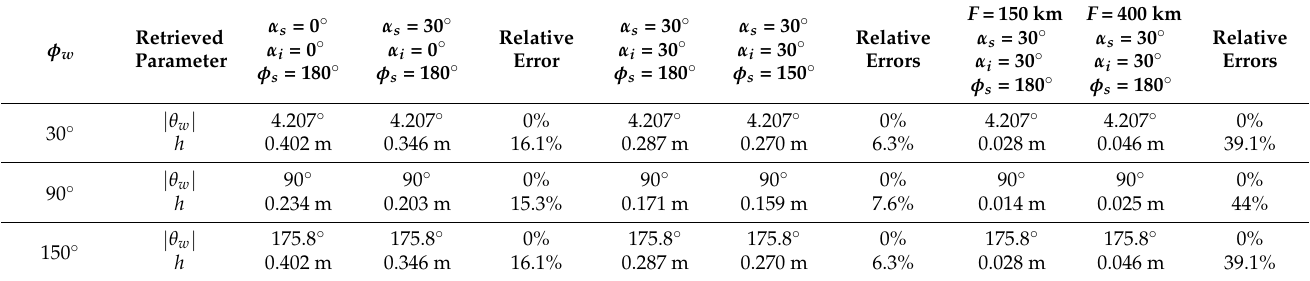
Table 3. | θ w | and h retrieval values as well as relative errors with WS = 15 m/s